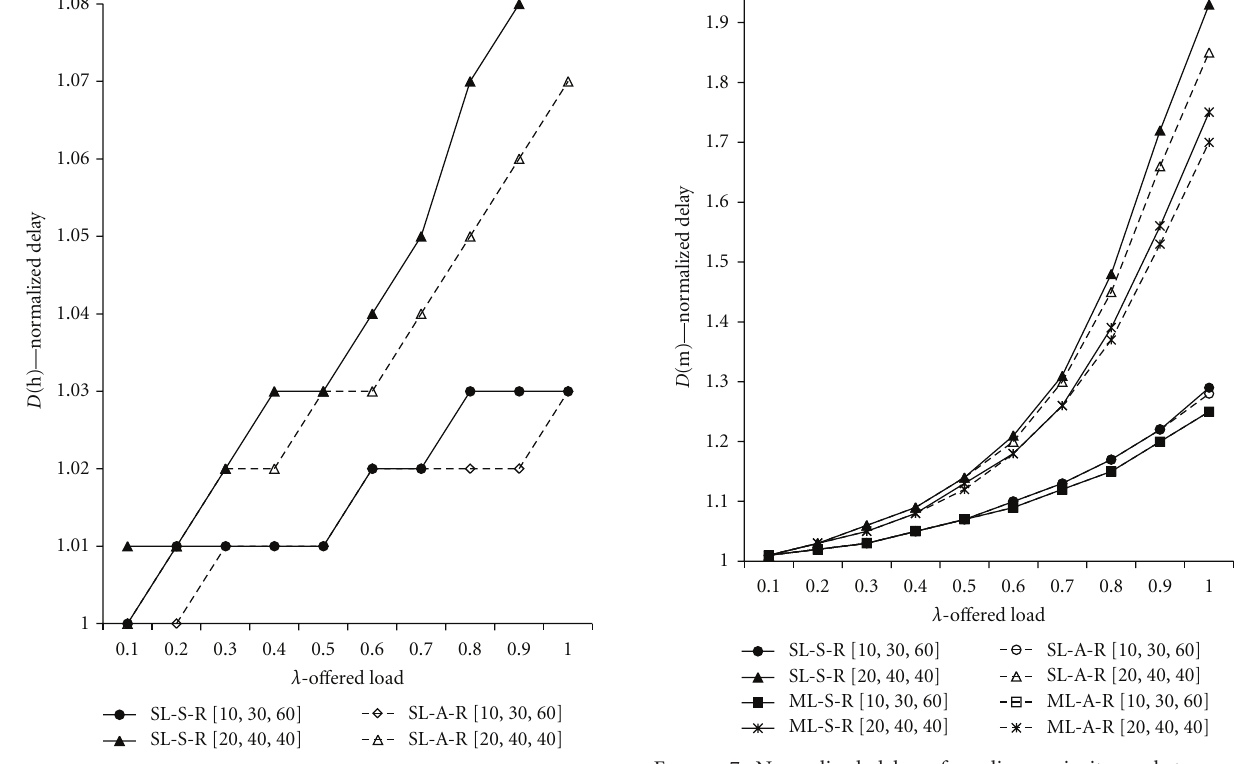
Figure 6: Normalized delay of high-priority packets versus o ff ered load.